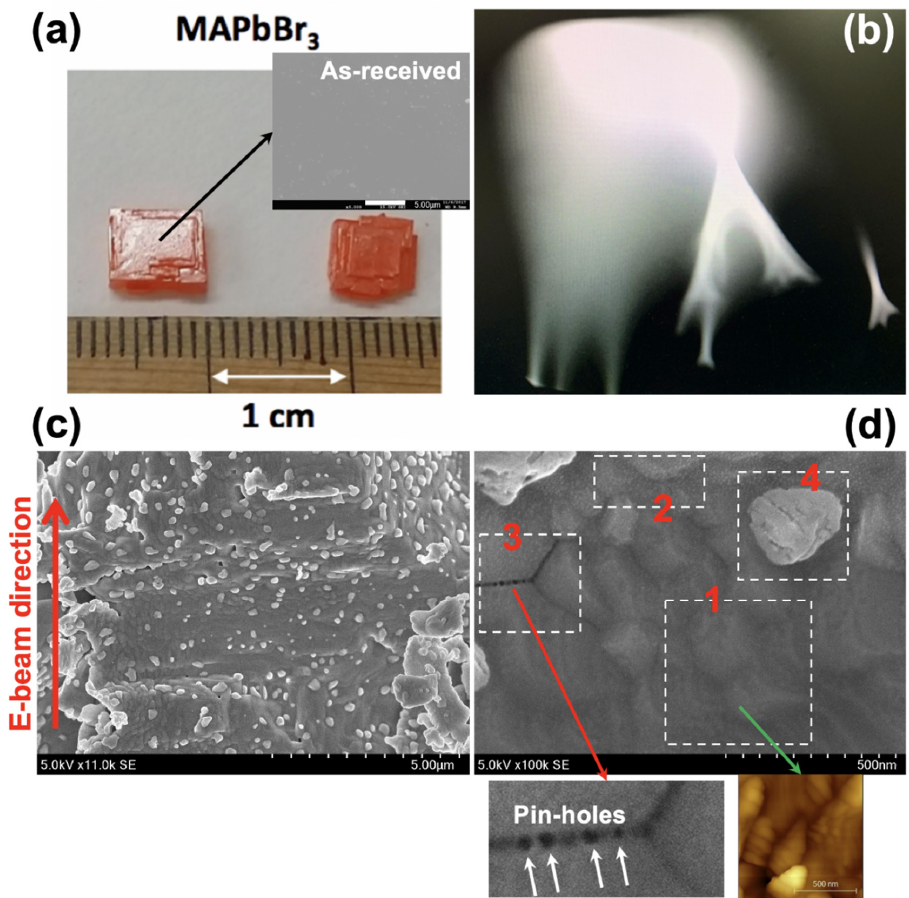
Figure 1. ( a ) The prepared MAPbBr 3 single crystals with the diameter of 0.6 cm. In the